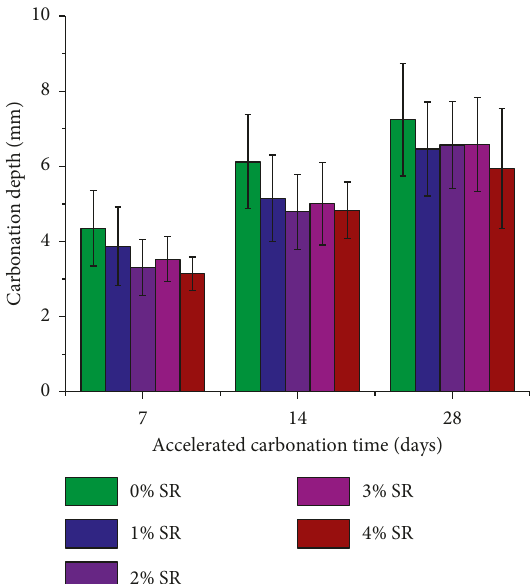
Figure 13: Carbonation depth of C-ISR after 7, 14, and 28days of accelerated carbonation.